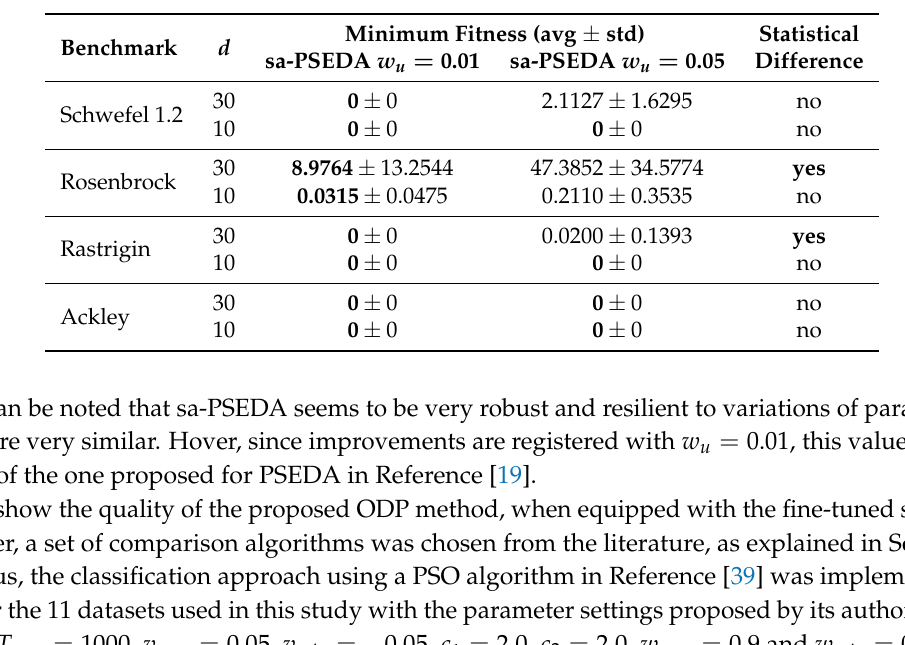
Table 2. Tuning results on numerical